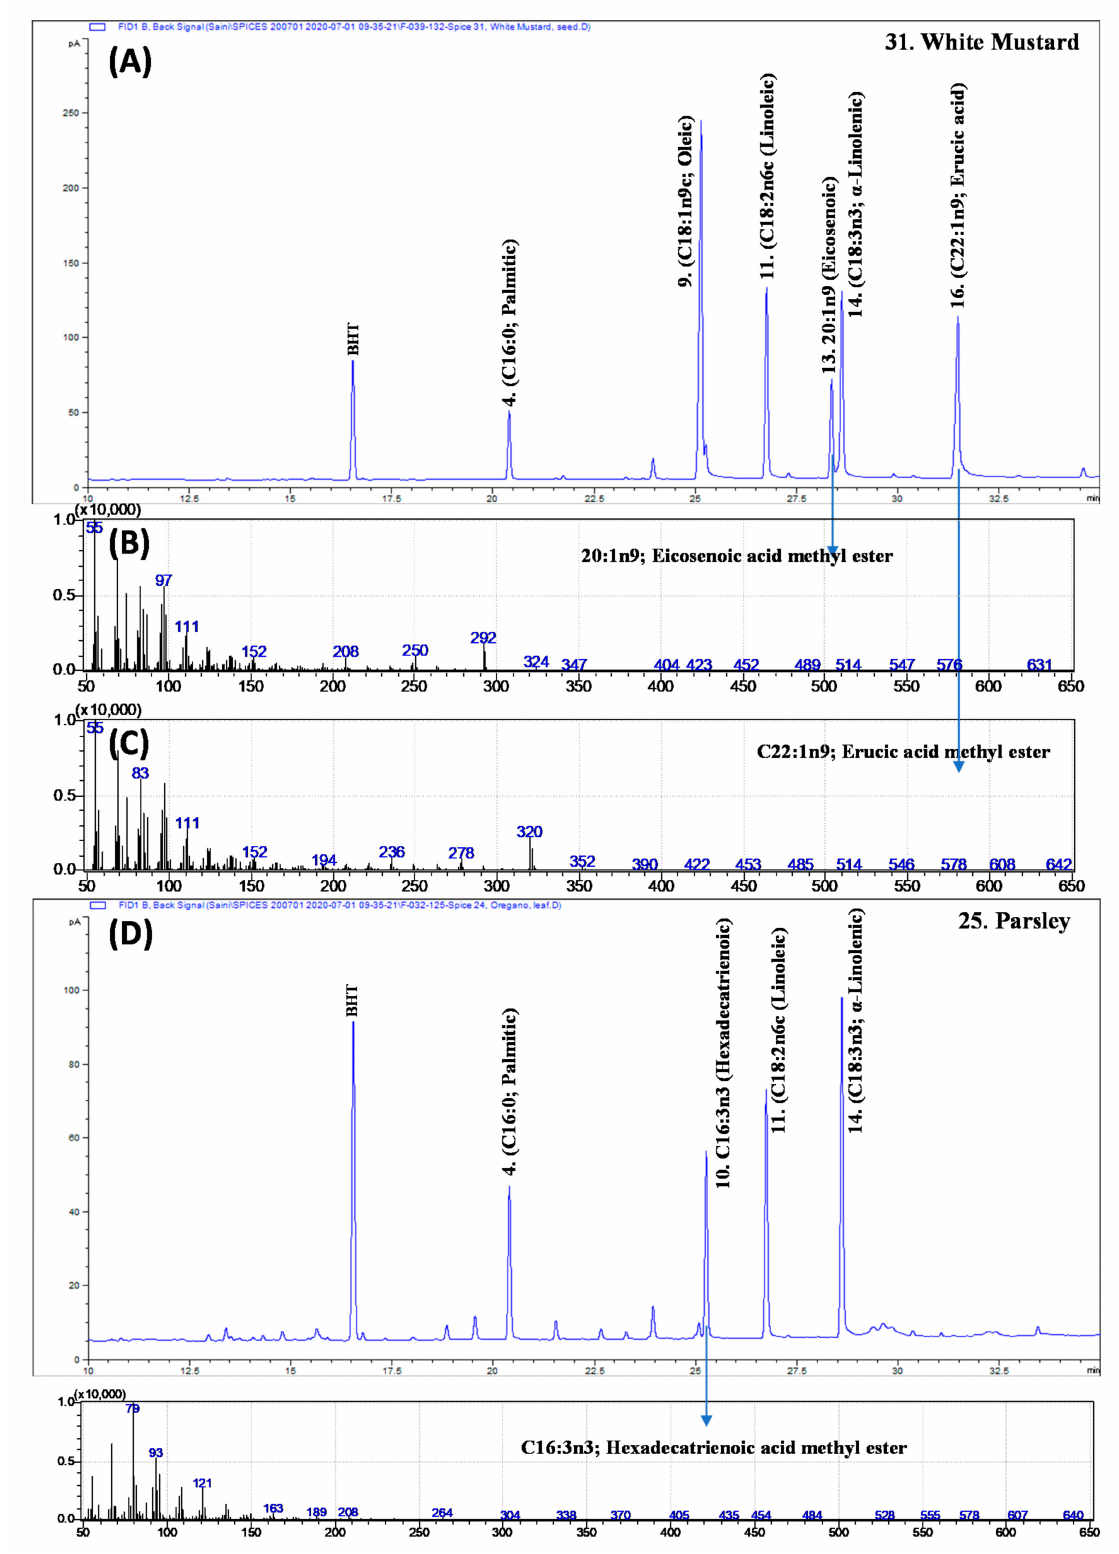
Figure 2. ( A ) The gas chromatography (GC)-flame ionization detection (FID) profiles of fatty acid methyl esters (FAMEs) of white mustard seeds. ( B , C ) The GC-mass spectrum of eicosenoic acid and erucic acid from white mustard seeds. ( D ) The GC-FID profiles of FAMEs of parsley leaves. The numbers, 4, 9, 10, 13, 14, and 16 correspond to peak numbers illustrated in Table 1. BHT: Butylated hydroxytoluene (A synthetic antioxidant used during lipid